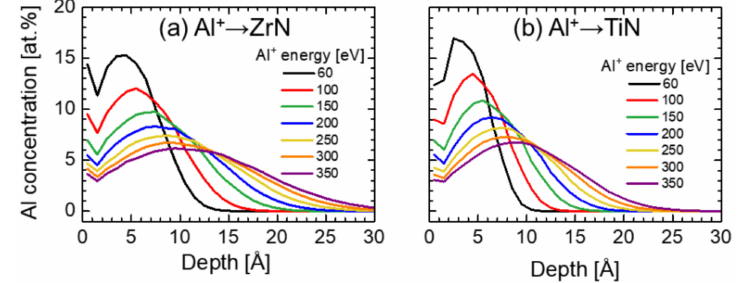
Figure 3. Al implantation profiles obtained from TRIDYN simulations as a function of Al + energy for metal-ions incident on ( a ) ZrN and ( b ) TiN.